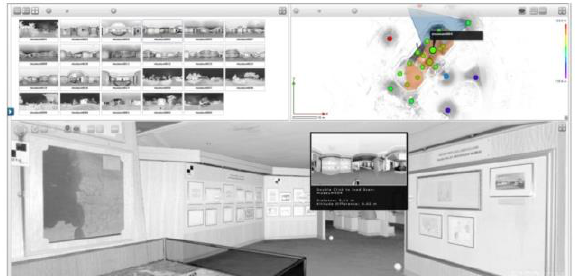
Figure 18. Bujang Valley Archaeological Museum in SCENE WebShare